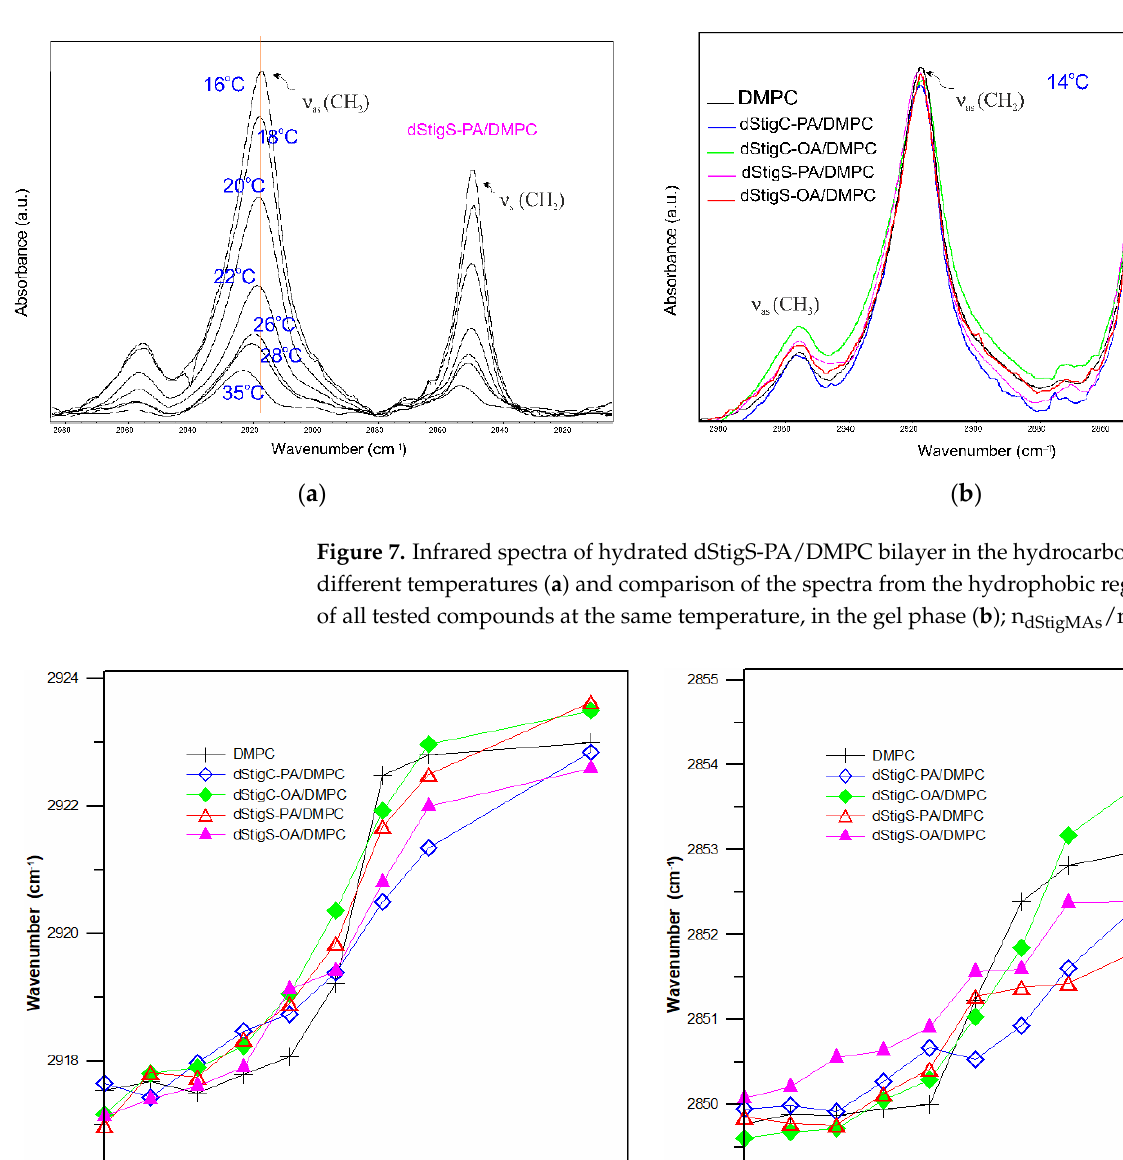
( b ) Figure 9. Infrared spectra of hydrated dStigS-PA/DPPC bilayer in the hydrocarbon chains region at different temperatures ( a ) and comparison of the spectra from the hydrophobic region of the bilayer of all tested compounds at the same temperature, in the gel phase ( b ); n dStigMAs /n DPPC = 0.20.